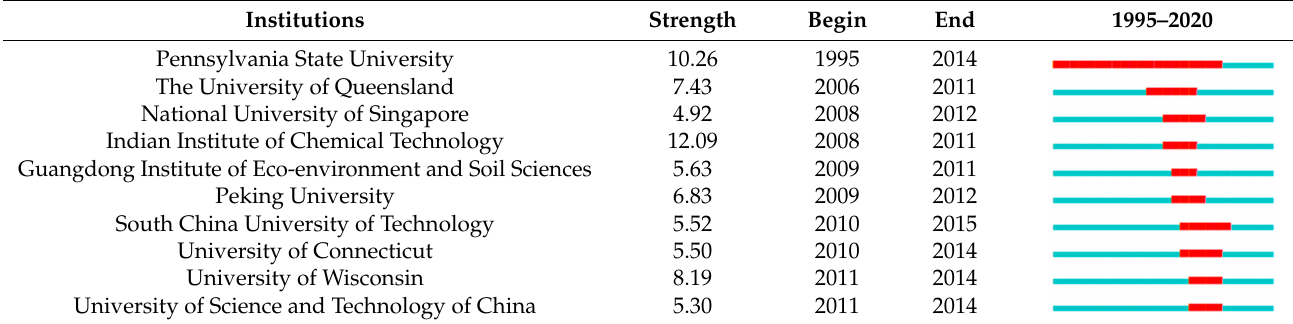
Table 10. The top 10 institutions with bursts.